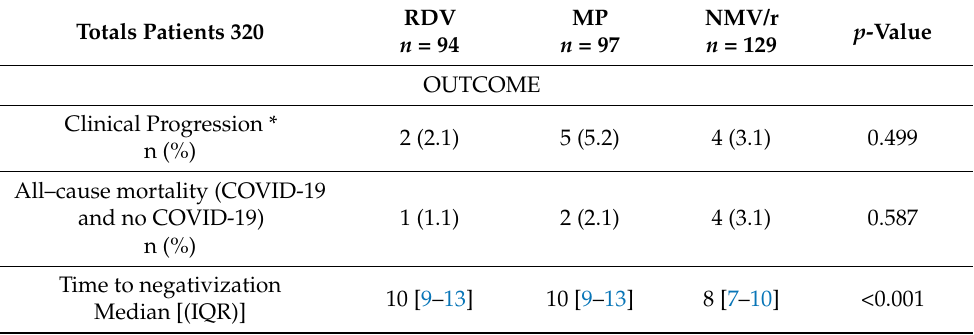
Table 4. Results of univariable analysis of immunocompromised subgroup by the endpoints: com- posite outcome (clinical progression), all-cause mortality (COVID-19 and non-COVID-19) and time to negativization. * Composite outcome: pneumonia, ARDS, COVID-19 Death, Non-COVID-19 Death. IQR: interquartile